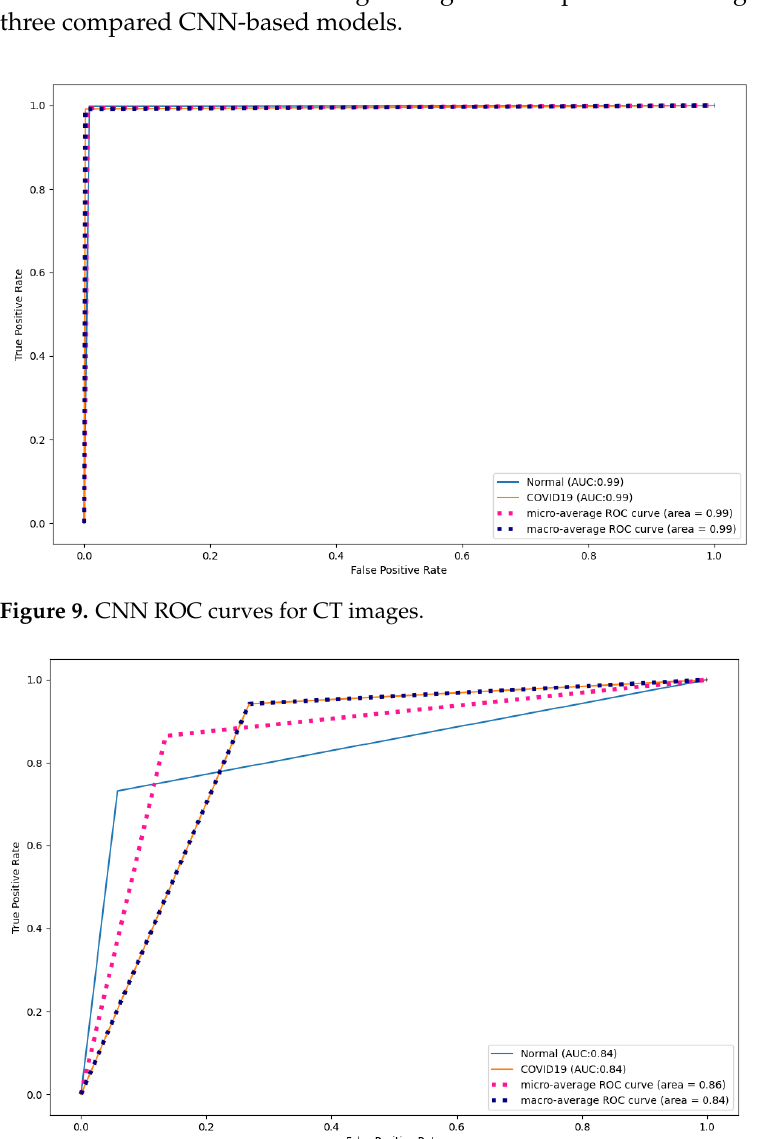
Figure 11. ResNet50 ROC curves for CT images.